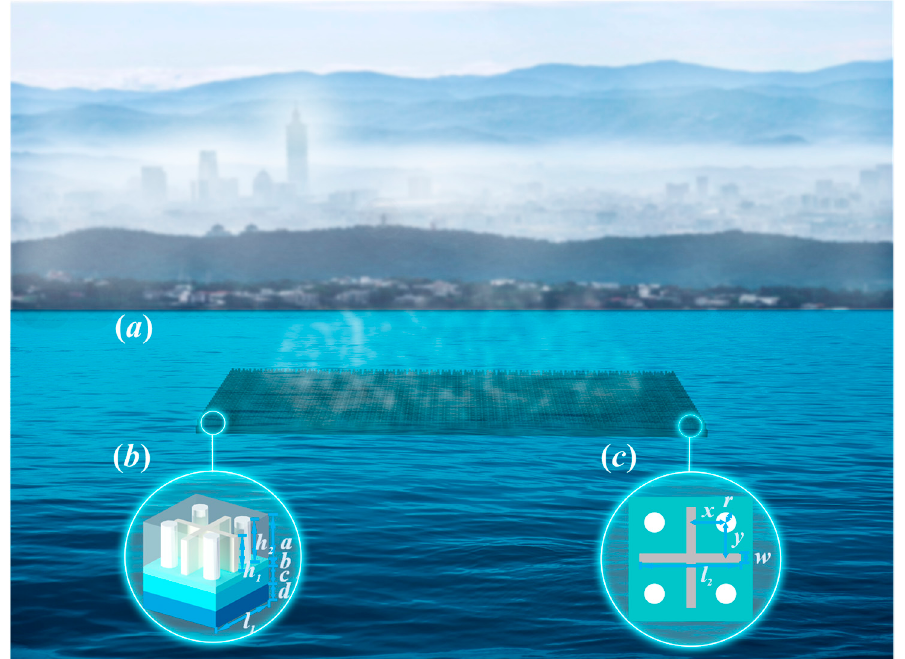
Figure 1. The schematic of the proposed absorber. ( a ) Three–dimensional schematic of the absorber. ( b ) The sectional view of a single unit. ( c ) The top view of a single unit of the absorber. A unit cell is shown in Figure 1b with its top view demonstrated in Figure 1c, respec- tively. The geometric parameters of the structure are represented by the following symbols: the thickness of the top SiO 2 layer, Al 2 O 3 dielectric layer, Ag reflective layer and Si substrate are represented by a , b , c and d , respectively. In addition, the periodicity of the unit is l 1 in both the x and y directions. The height, length and width of the cross nanostructures on the top are indicated by h 1 , l 2 and w , respectively. Moreover, the height and radius of the nanocylinder are respectively h 2 and r , and the distances from the horizontal and vertical coordinates to the center of the four nanocylinders are represented by x and y , respectively. The optimized values of those parameters are as follows: a = 245 nm; b = 20 nm; c = 100 nm; d = 300 nm; l 1 = 240 nm; l 2 = 206 nm; h 1 = 160 nm; h 2 = 220 nm; w = 20 nm; r = 25 nm; and x = y = 75 nm. These parameters are set as default unless otherwise declared.